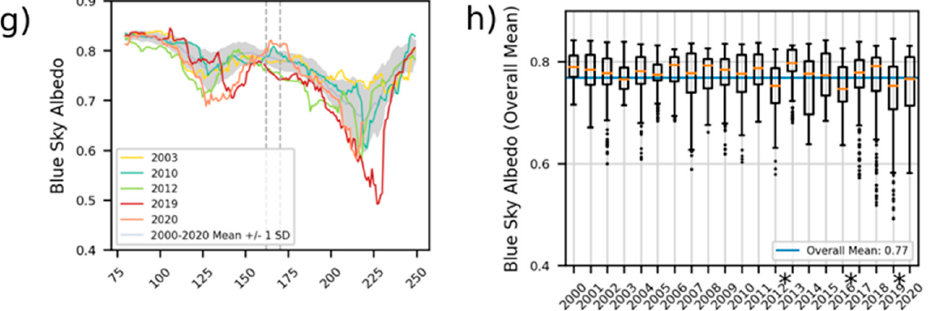
Figure 4. MODIS albedo trajectory for four areas of interest (AOIs): the west coast catchments AOI, the entirety of Greenland, the Russell Glacier catchment, and the Helheim Glacier catchment, all as identified in Figure 1. The left panels show the daily mean blue-sky albedo values for the 2000–2020 mean +/ − one standard deviation, as well as the extreme melt years of 2003, 2010, 2012, and 2019. The vertical dashed lines indicate the period of extensive melt in 2019. The right panels show box plots of mean annual albedo, showing outliers as black dots, and with a blue horizontal line to indicate the overall mean of the given AOI. The asterisks above the year labels indicate years that were statistically separable from the 2000–2020 mean at a 99% confidence level.